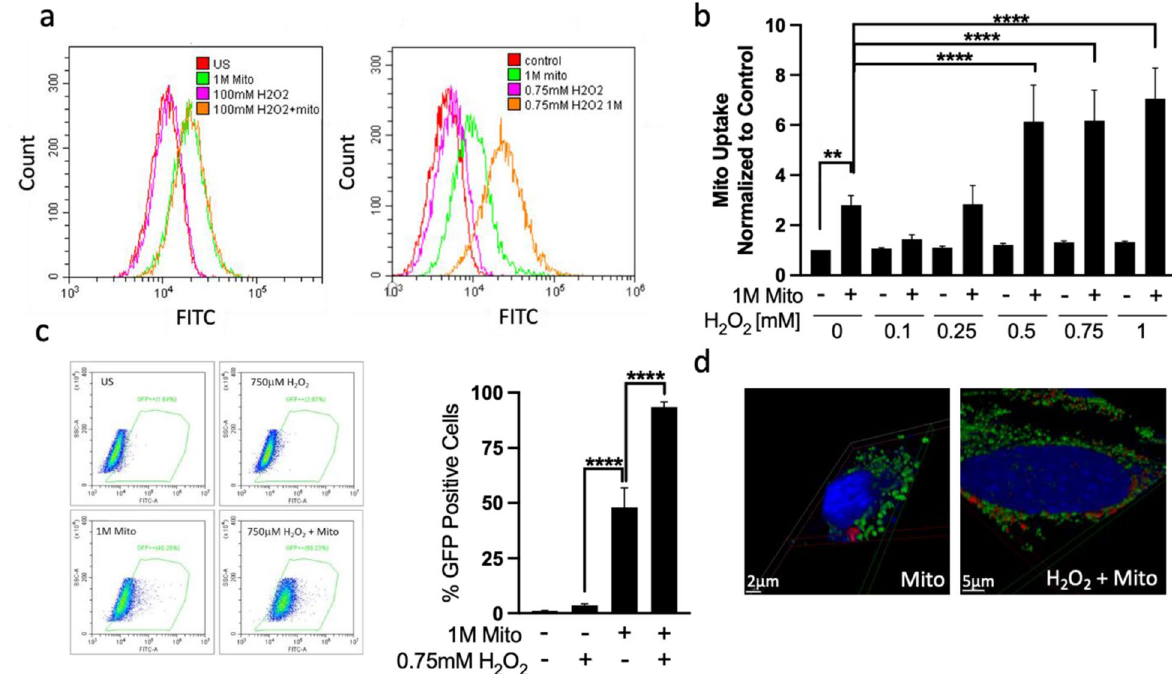
Figure 4. Oxidative stress facilitates mitochondrial uptake by retinal ganglion precursor-like cells. Cells were exposed to increasing concentrations (as indicated) of H 2 O 2 for 1 hour and then transplanted with 1 million (M) MTG-stained mitochondria. Mitochondrial internalization was determined by flow cytometry 24 hours following transplantation. Enhanced mitochondrial uptake by H 2 O 2 concentrations higher than 0.5 mM is demonstrated by representative histogram plots ( a ) and by a quantitative bar graph ( b ). n = 4, **p < 0.005 compared to control, non-transplanted cells; ****p < 0.0001 compared to mitochondria treatment group. ( c ) The percentage of cells that contain exogenous mitochondria (GFP Positive population) is demonstrated by representative histogram plots (left) and by a quantitative bar graph (right). n = 6, * p < 0.0001. ( d ) Three dimensional view of confocal planes, showing close localization of exogenous mitochondria (red, MTR-stained mitochondria) and endogenous mitochondria (green, stained with TOMM20